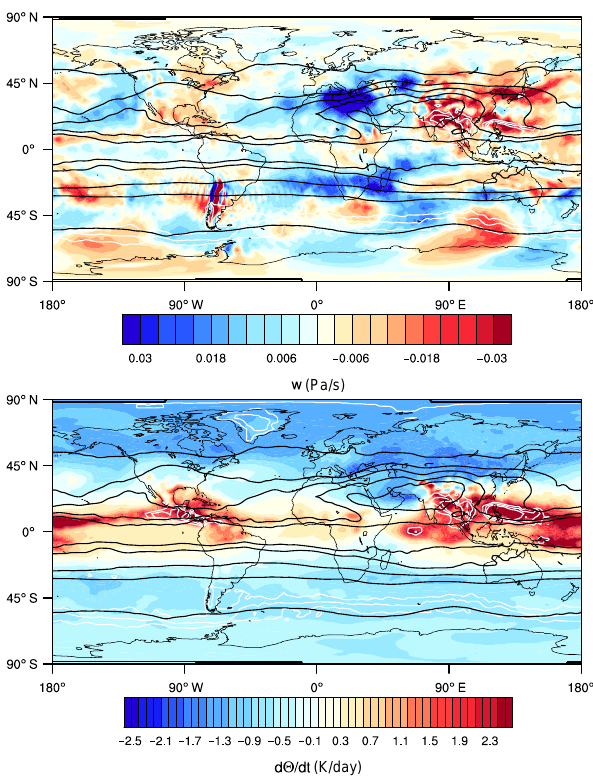
Figure 8. Monthly mean vertical velocity (top panel, in pascal per second; note the flipped color bar) and d (cid:50) /d t (bottom panel, in kelvin per day) at 360K together with PV (black contours, for ± 8, 4, 2, 1 and 0.7PVU) and OLR (white contours, at 190, 200 and 210Wm − 2 ) for July 2006.